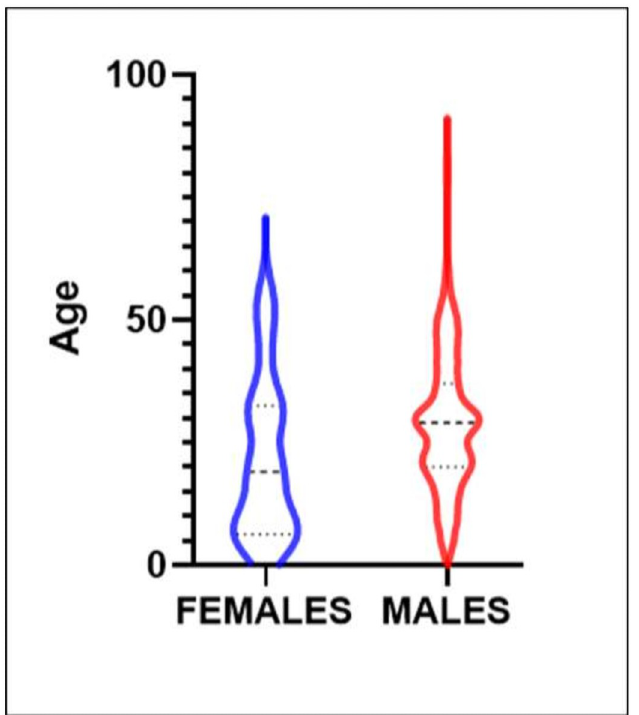
Fig 2. Age distribution of